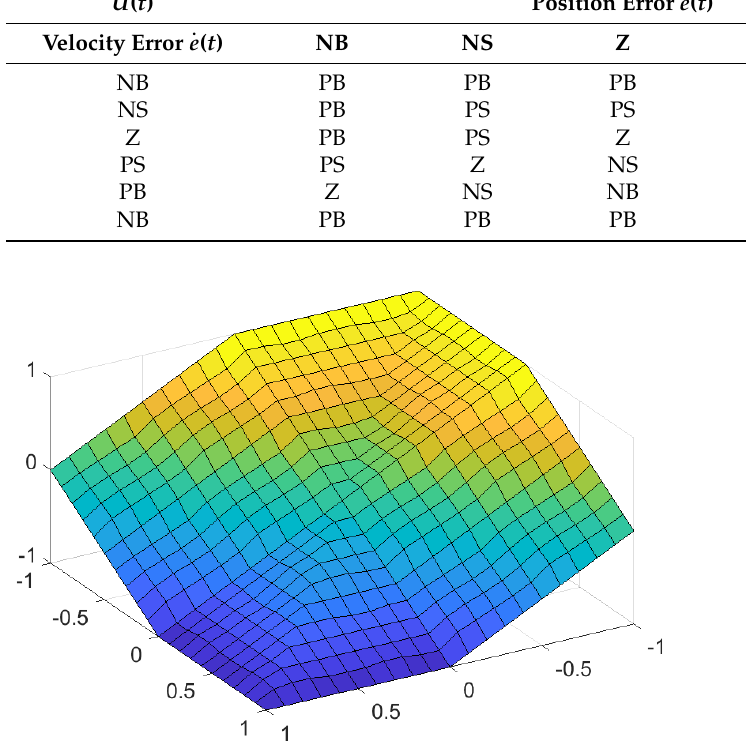
. e ( t ), and U ( t ) based on